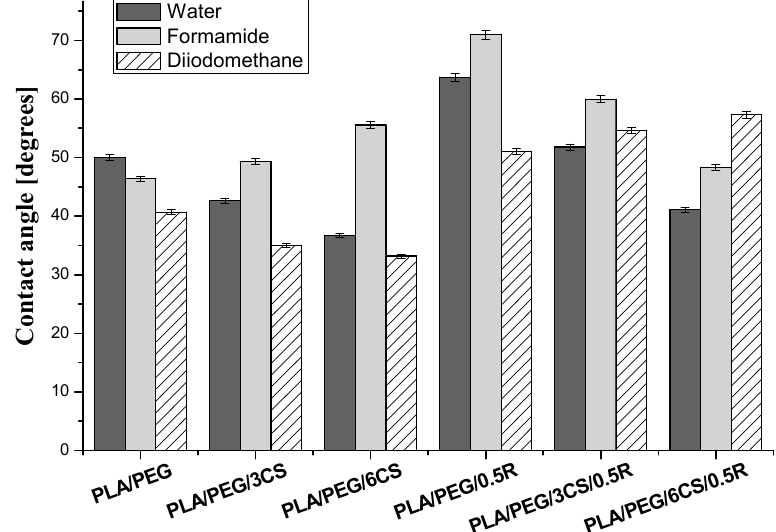
Figure 8. Contact angle variation for plasticized PLA, PLA / CS biocomposites with or without rosemary ethanolic extract.